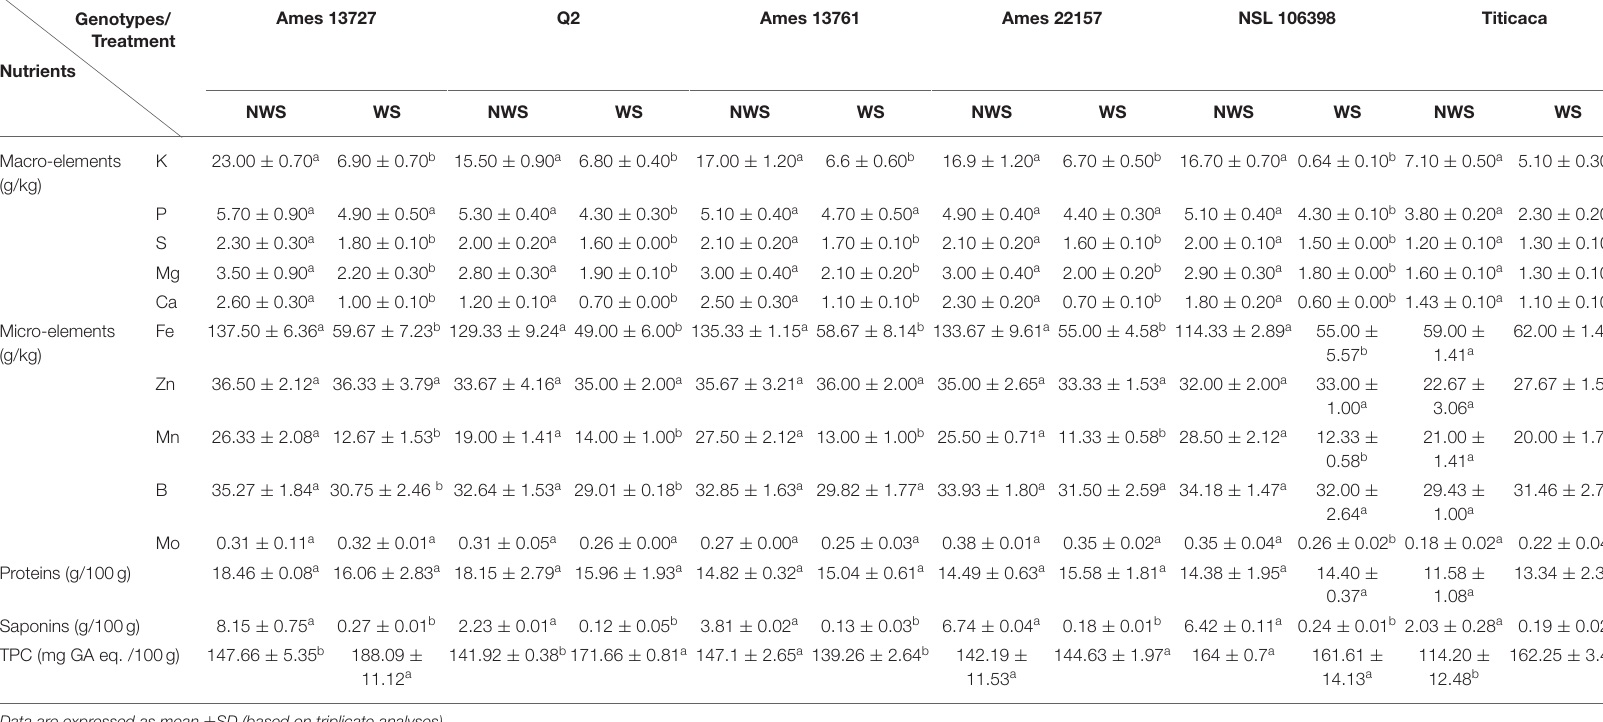
Data are expressed as mean ± SD (based on triplicate analyses). a − b Different superscript letters in the same line for each genotype indicate the significant difference (p < 0.05). NWS, Non-washed seeds; WS, Washed seeds; TPC, Total phenolic